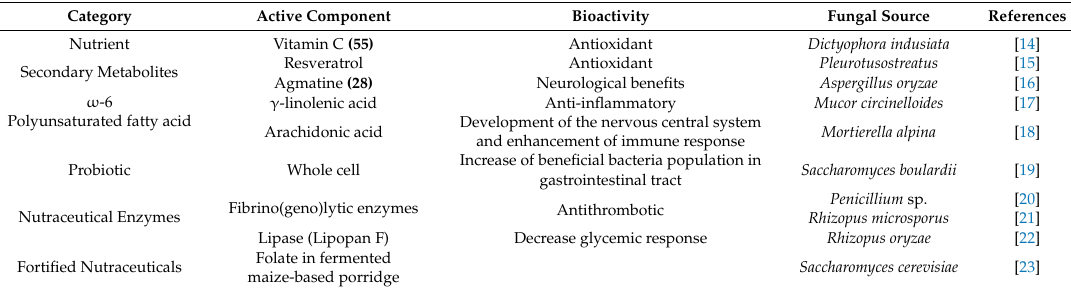
Table 1. Examples of food additives and nutraceuticals from